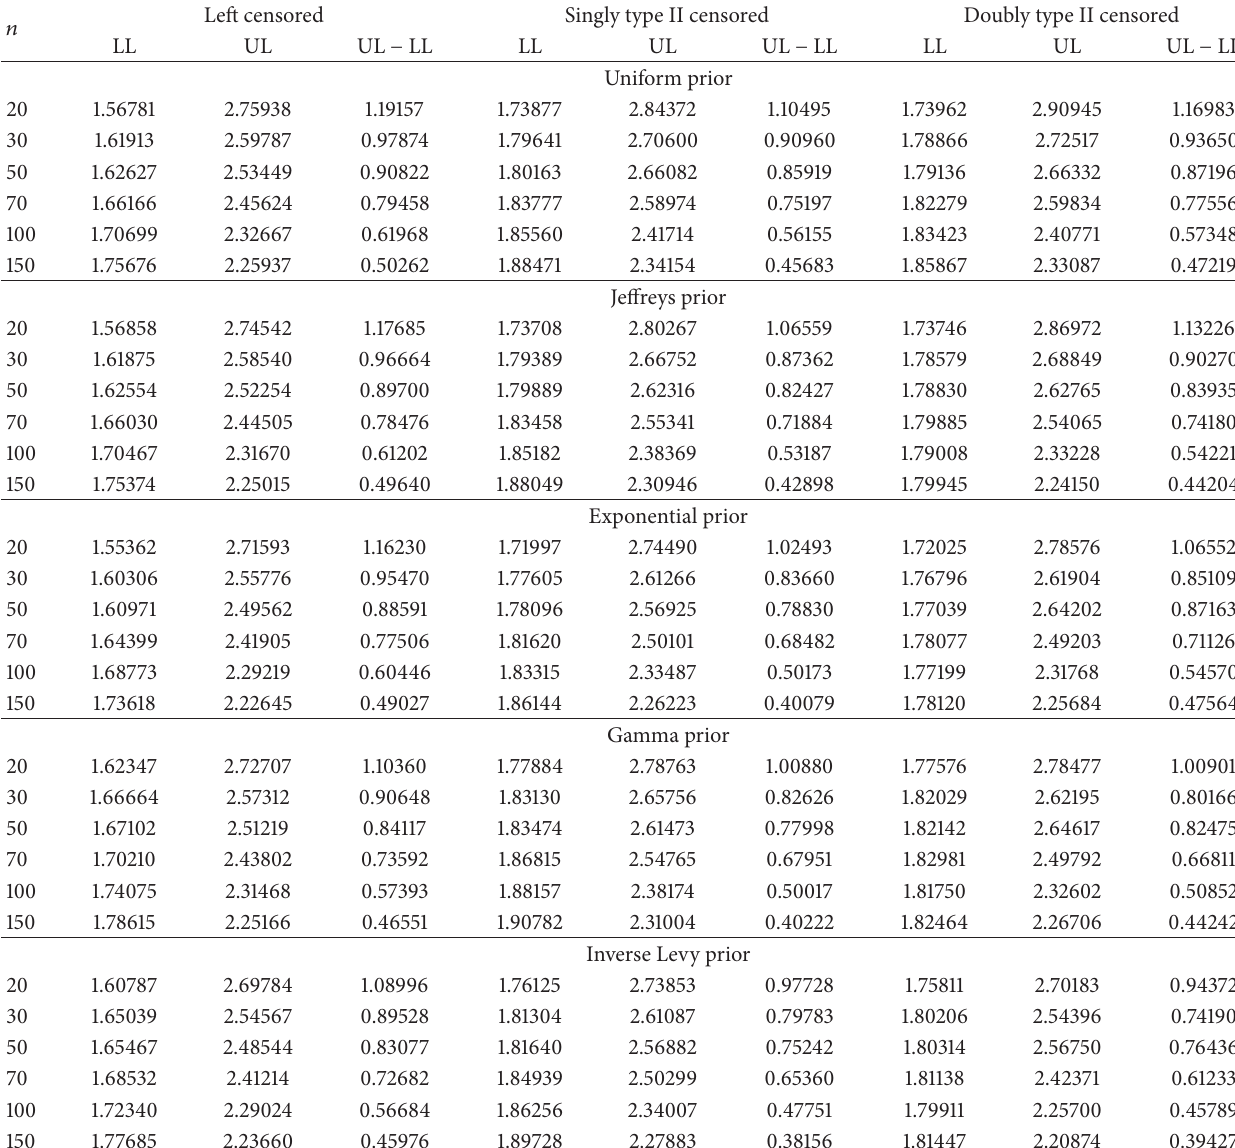
Table 6: 95% credible intervals under different priors and censoring techniques for Ψ = 2